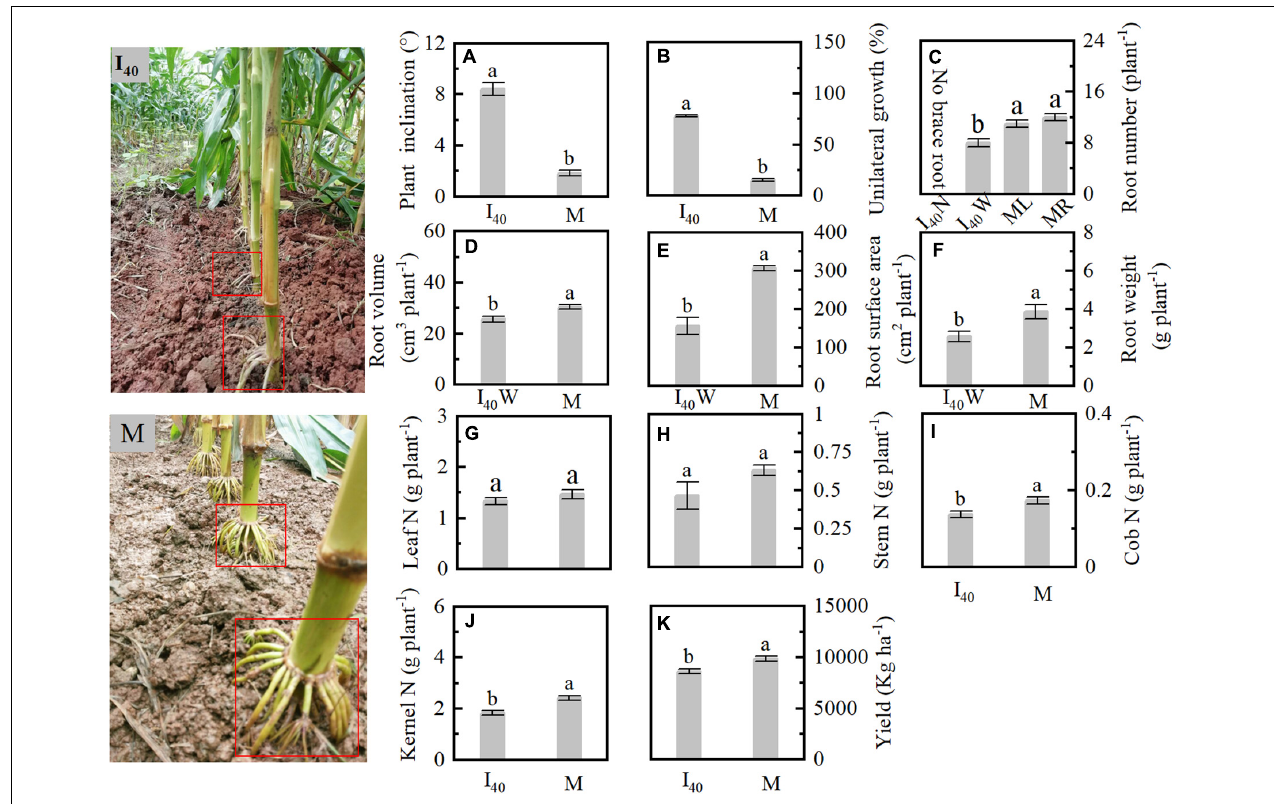
FIGURE 1 | Plant inclination, root morphology, N accumulation of organs, and yield in Study 1 in 2019. (A) Plant inclination at stage V14 (14th leaf stage). (B) Brace unilateral root growth ratio. (C–F) Brace root number, volume, surface area, and weight per plant at 25 days after flowering (25 DAF). (G–J) The N accumulation of leaf, stem, cob, and kernel per plant at maturity. (K) Kernel yield at maturity. I 40 : the narrow (N) and wide (W) row spacing of 40 + 180 cm in intercropping. ML and MR: the left (ML) and right (MR) sides of the maize plant of monoculture (M). Data with the different letters are significantly different ( p <